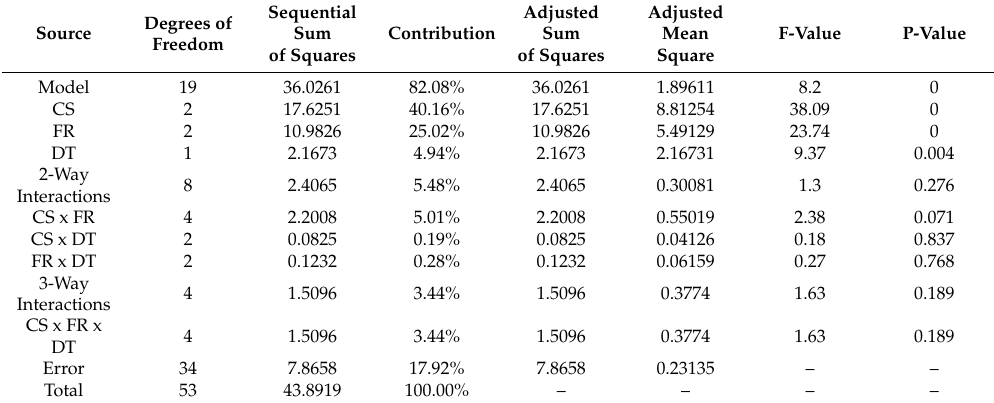
Table 7. ANOVA for surface roughness.